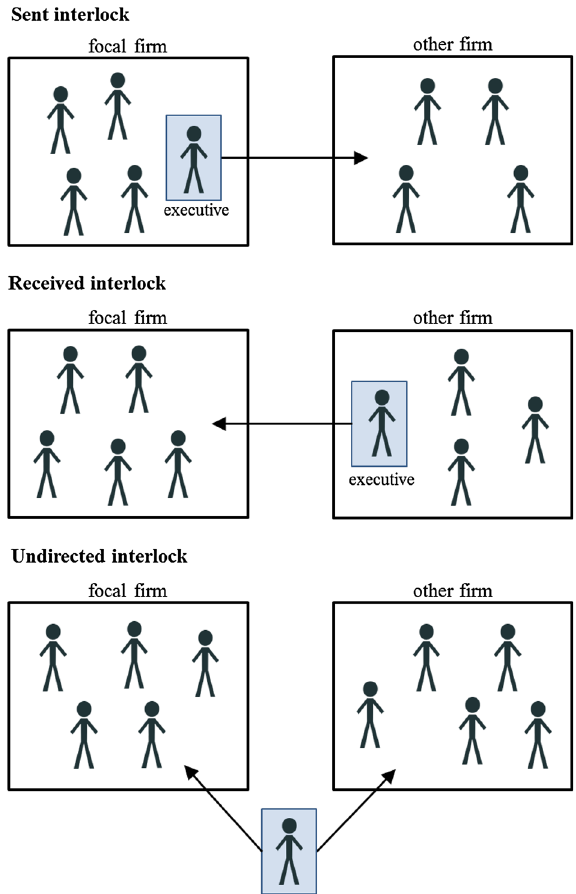
Fig. 1 Sent, received and undirected